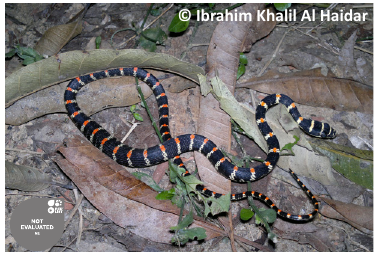
Image 4. Boiga ochracea Tawny Cat Snake